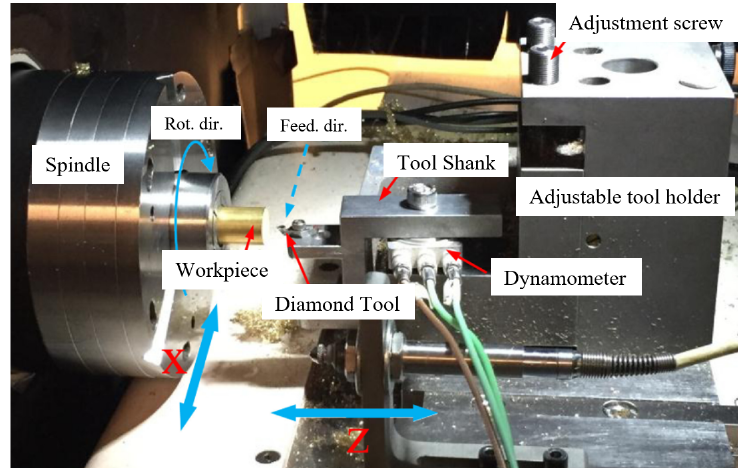
Figure 8. Diamond turning setup [65]. Reprinted with permission from [65]; 2018 Elsevier.